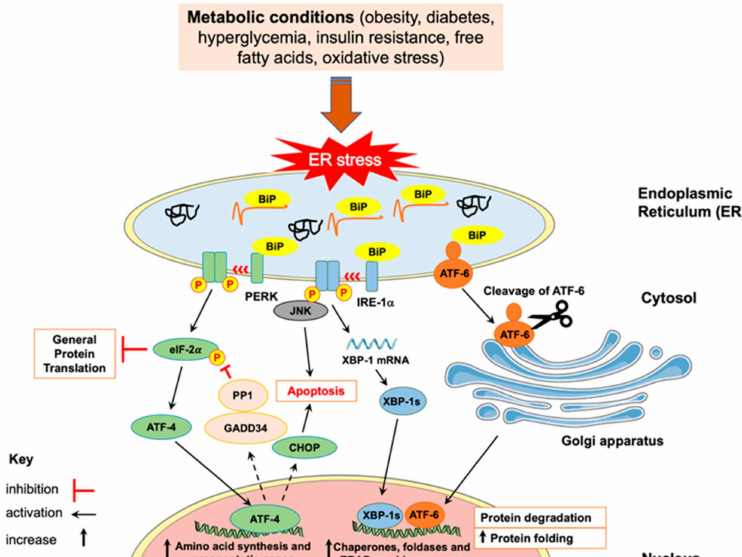
Figure 1. Cellular pathways involved in unfolded protein response (UPR) and endoplasmic reticulum (ER) stress response activation. At resting state, the UPR stress sensors, protein kinase R (PKR)-like ER kinase (PERK), inositol-requiring enzyme (IRE-1 α ) and activating transcription factor (ATF-6) are kept in place by the chaperone immunoglobulin heavy chain binding protein (BiP). During metabolic stress conditions, such as in obesity and diabetes, accumulation of unfolded / misfolded proteins in the ER lumen leads to dissociation of BiP from UPR stress sensors to fix the unfolded / misfolded proteins inside the ER, while the stress sensors of UPR become available to activate downstream signaling. (i) PERK autophophorylates and dimerizes to become active and activates eukaryotic initiation factor (eIF-2 α ) through phosphorylation. Active eIF-2 α attenuates general translation of proteins but selectively enhances the translation of ATF-4, which is then moved to the nucleus to promote transcription of genes involved in amino acid synthesis and apoptosis. ATF-4 is also involved in the negative feedback of PERK signaling by enhancing transcription of growth arrest and DNA damage inducible protein (GADD34) that activates protein phosphatase 1 (PP1) leading to PERK dephosphorylation and hence inactivation; (ii) IRE-1 α autophosphorylates and dimerizes to be activated, then it splices X box-binding protein 1 (XBP-1) mRNA to the active XBP-1s. XBP-1s then translocates into the nucleus; (iii) ATF-6 is cleaved by proteases in the Golgi apparatus to become active. Both XBP-1s and cleaved ATF-6 move to the nucleus and facilitate the transcription of genes involved in protein folding and degradation (ER-associated degradation (ERAD) machinery). c-Jun-NH2-terminal kinase (JNK) proinflammatory and proapoptotic pathway is closely related to IRE-1 α and can be activated after prolonged ER